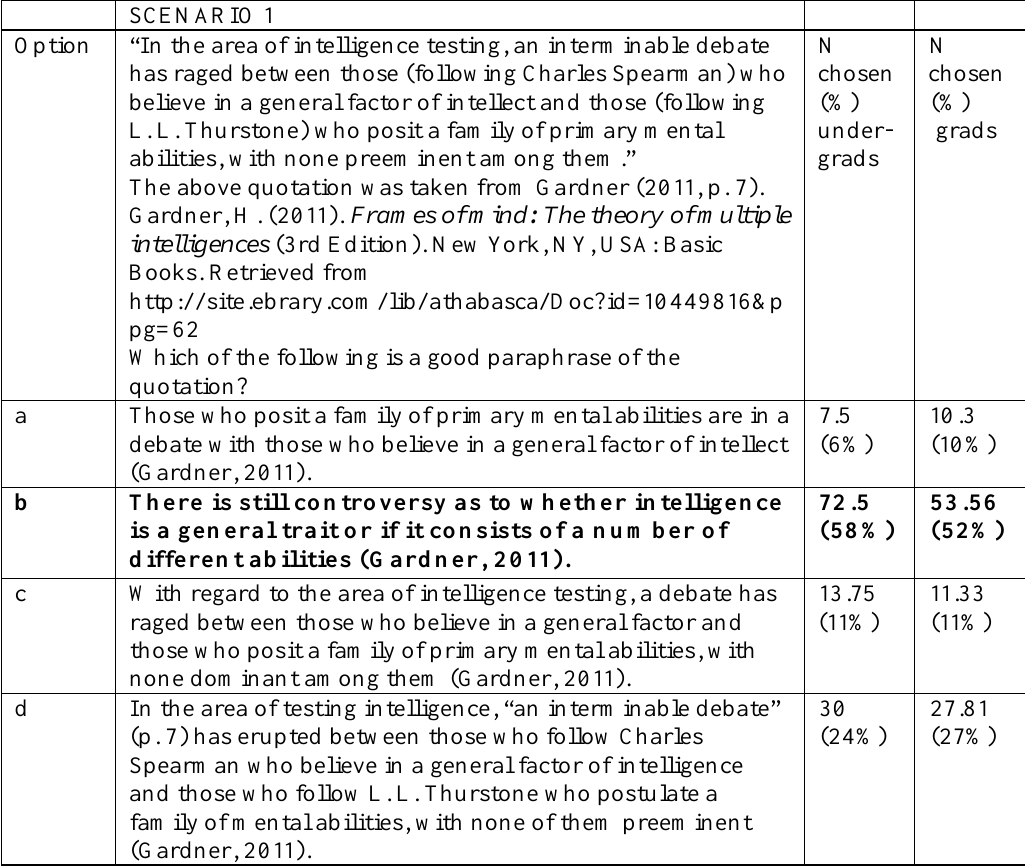
Number and Percentages of Options Chosen for the Scenarios for the University Group SCENARIO